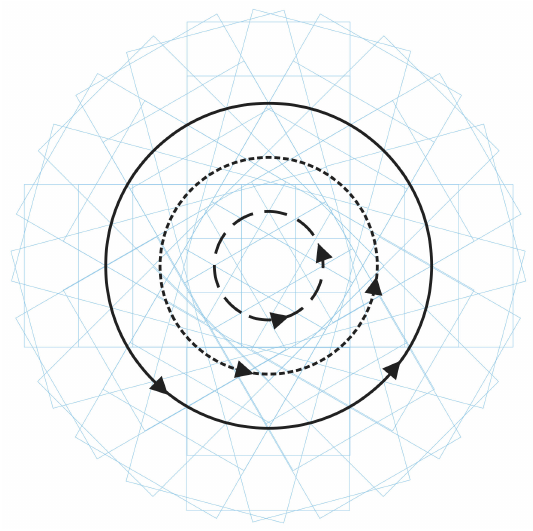
Figure 3. Scanning path of large surface with round